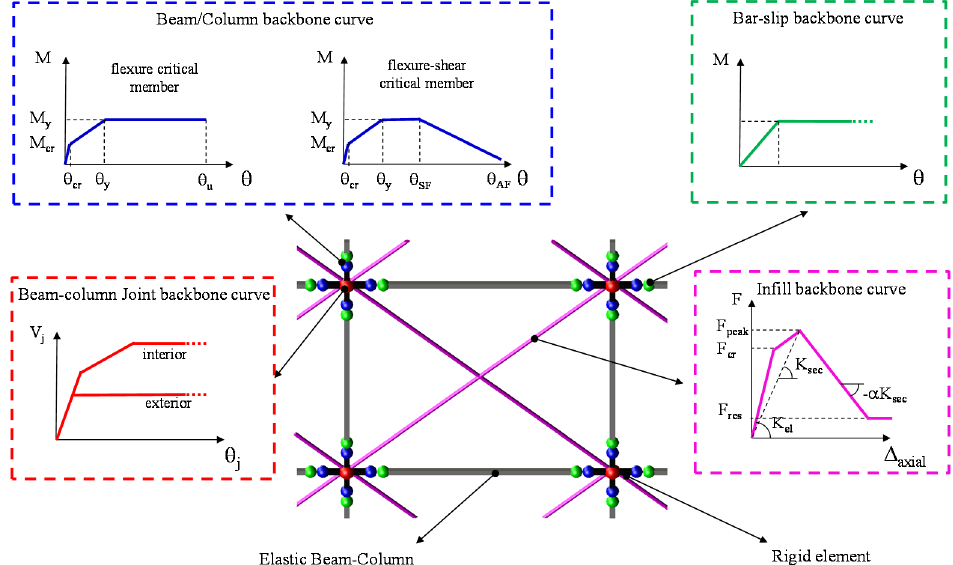
Figure 5. Numerical modeling for frame and infill elements (for further details refer to Gaetani d’Aragona et al. [68,69]).